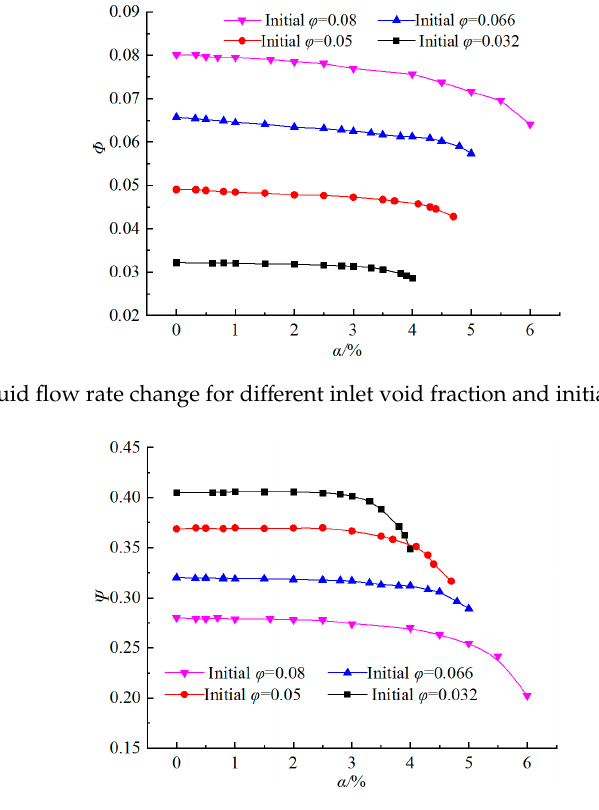
Figure 7. Head pump change for different inlet void fraction and initial water flow rates.